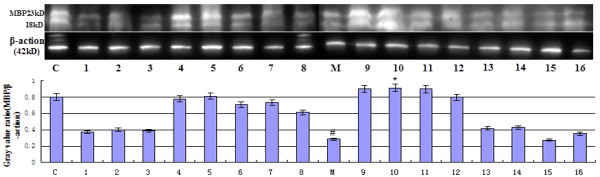
The effect of picroside II on the expression of MBP detected by Western blot. β-action was used as a loading paraqmeter. Line 1–16 were the treatment group rats which were treated in different time with different doses. In model group (M), the RCP of MBP was observably lower than that in control group (C) (#P < 0.05), while markedly increased after treatment by picroside II (*P < 0.05 vs model group).